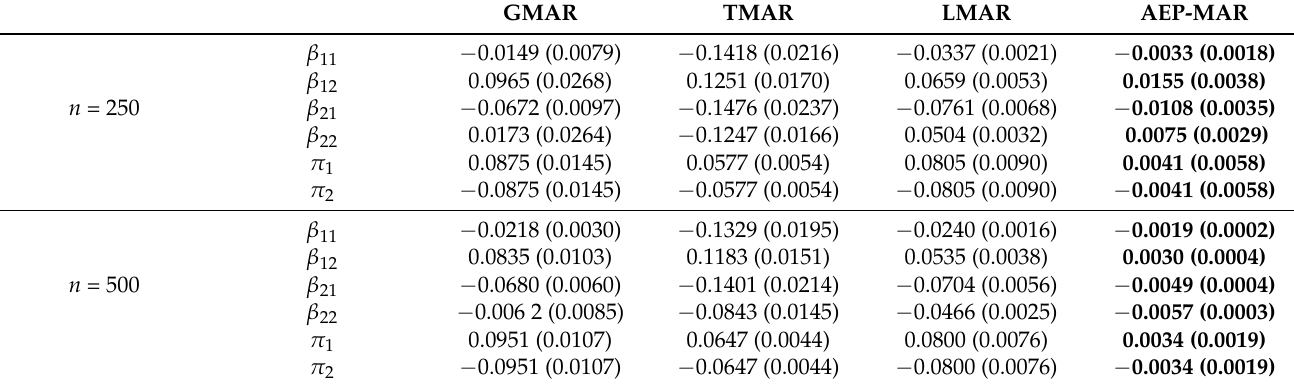
Table 7. Simulation results for Scenario 5